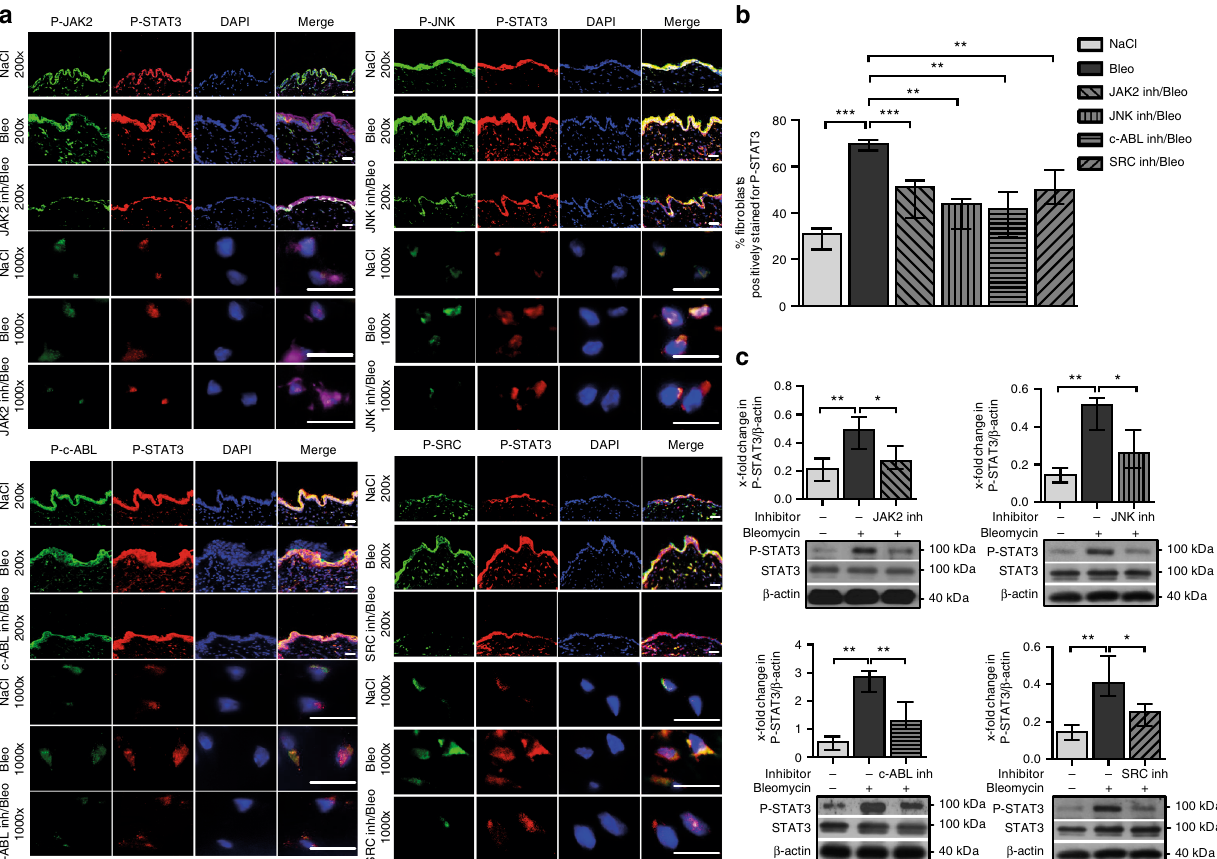
Fig. 5 Pharmacological inhibition of JAK2, JNK, c-ABL, and SRC reduces levels of P-STAT3 in bleomycin-challenged mice. a – c a Representative images with b quanti fi cation of immuno fl uorescence stainings and c western blot analyses with quanti fi cation of P-STAT3 in the skin of bleomycin-challenged mice treated with the JAK2 inhibitor TG101209, the JNK inhibitor CC-930, c-ABL inhibitor imatinib mesylate, or the SRC inhibitor SU6656. Control mice injected with NaCl and bleomycin-challenged receiving vehicle treatment served as controls. N ≥ 4 mice and 3 technical replicates per group for all experiments. Expected band size for P-STAT3 and STAT3 are 79 kDa (lower faint band) and 86 kDa (higher intense band) and the ladder represents 100 kDa. Beta-actin (expected molecular weight/size 42 kDa) is shown by ladder at 40 kDa. Magni fi cations of 200-fold and 1000-fold are shown for all immuno fl uorescence stainings. Horizontal scale bar, 100 μ m. Results are shown as median ± interquartile range (IQR). Signi fi cance was determined by Mann – Whitney test, as compared to sham-treated or bleomycin-challenged mice, respectively. * P < 0.05; ** P < 0.01, *** P <